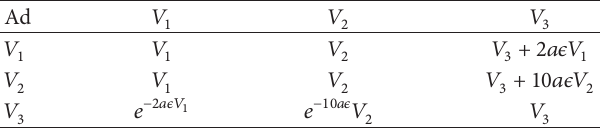
Table 4: Adjoint table of the Lie algebra of (2.3) . Ad